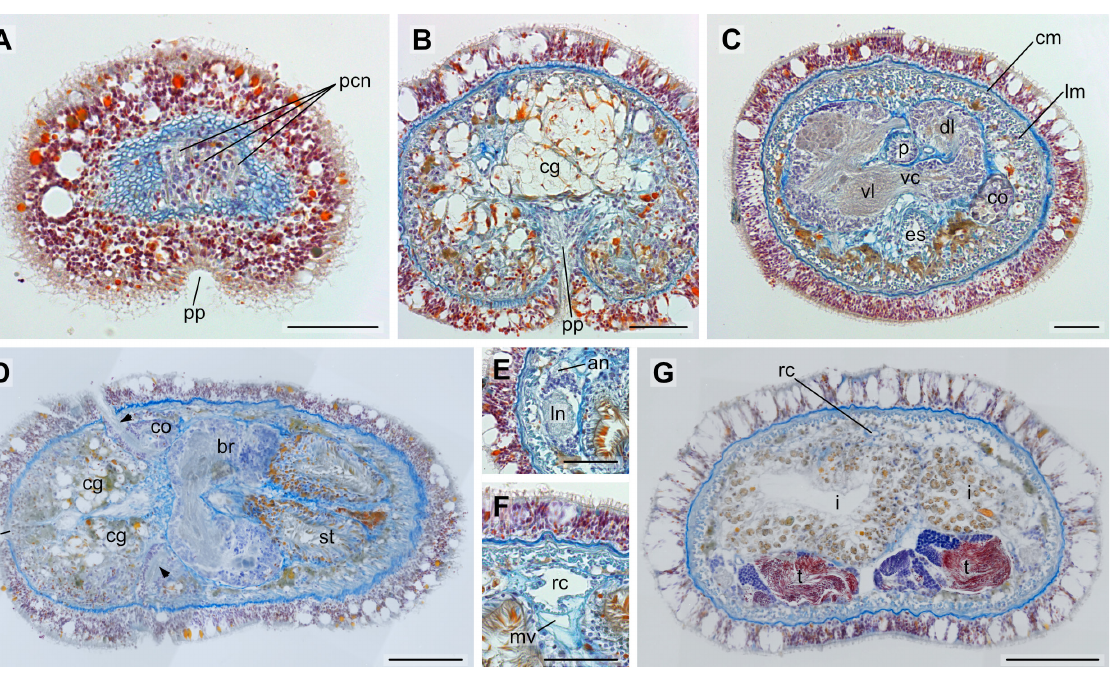
Fig. 9. Chernyshevia escarpiaphila gen. et sp. nov. A–C . Paratype (MZUCR Nemertea Collection MZUCR-104-01), transverse histological sections. D–G . Holotype (SIO-BIC N279), histological sections. A . Anterior tip of head with proboscis pore. B . Region anterior to cerebral ganglia with well- visible cephalic glands. C . Brain region depicting ventral commissure. D . Longitudinal section through brain region showing the cerebral canal (arrowheads). E . Lateral nerve cord with accessory nerve in the stomach region. F . Rhynchocoel in stomach region with well-visible mid-dorsal vessel. G . Intestinal region with testes. Abbreviations: an = accessory nerve; br = brain; cg = cephalic gland; cm = circular muscle layer; co = cerebral organ; dl = dorsal brain lobe; es = esophagus; i = intestine; lm = longitudinal muscle layer; ln = lateral nerve cord; mv = mid-dorsal vessel; p = proboscis; pcn = precerebral nerves; pp = proboscis pore; rc = rhynchocoel; st = stomach; t = testis; vc = ventral commissure; vl = ventral brain lobe. Scale bars = 100